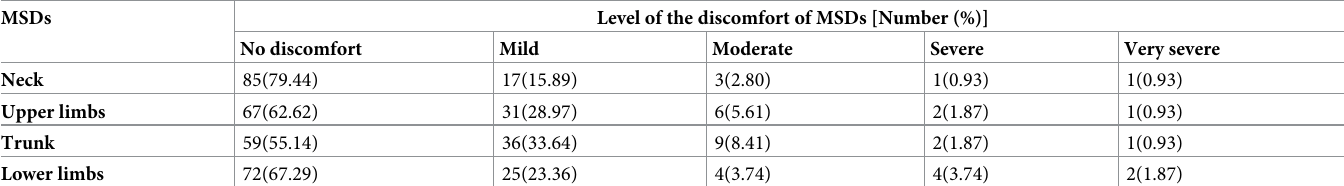
Table 3. The number and percentage of potato-chip processing workers classified by level of self-report discomfort of MSDs (n = 107).